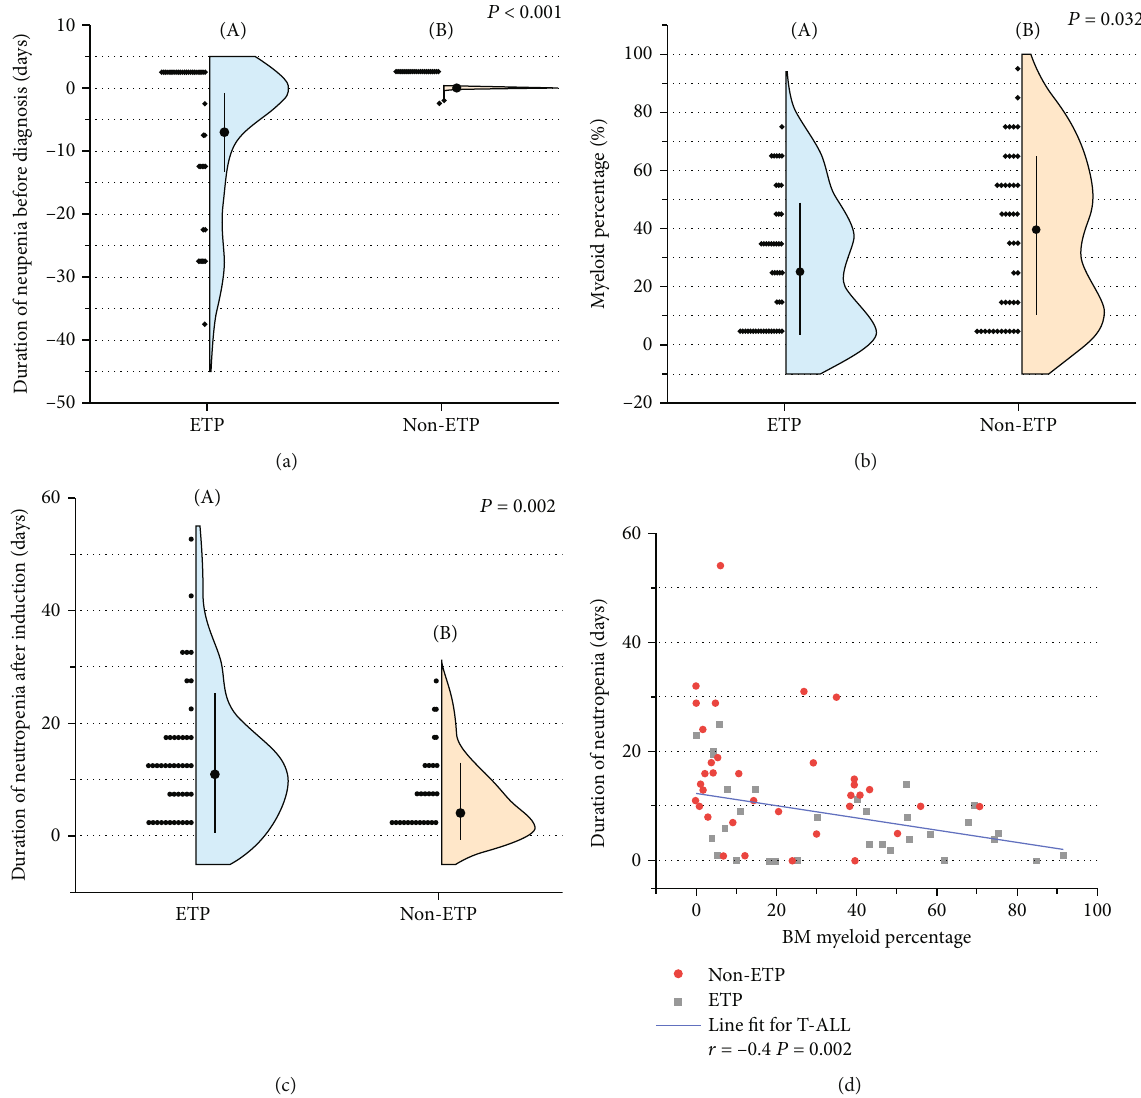
Figure 2: Clinical characteristics of the ETP and non-ETP cohorts. (a) Comparison of neutropenia at prediagnosis between the ETP (A) and non-ETP (B) patients. (b) Analysis of myeloid percentage in the bone marrow in the ETP (A) and non-ETP (B) cohorts. (c) Comparison of neutropenia duration during induction in the ETP (A) and non-ETP (B). (d) Linear relationship analysis between the myeloid percentage and neutropenia duration during induction, ETP is shown as red-dot and non-ETP as solid black square. Quantitative variables are expressed as mean (a) or median (b,